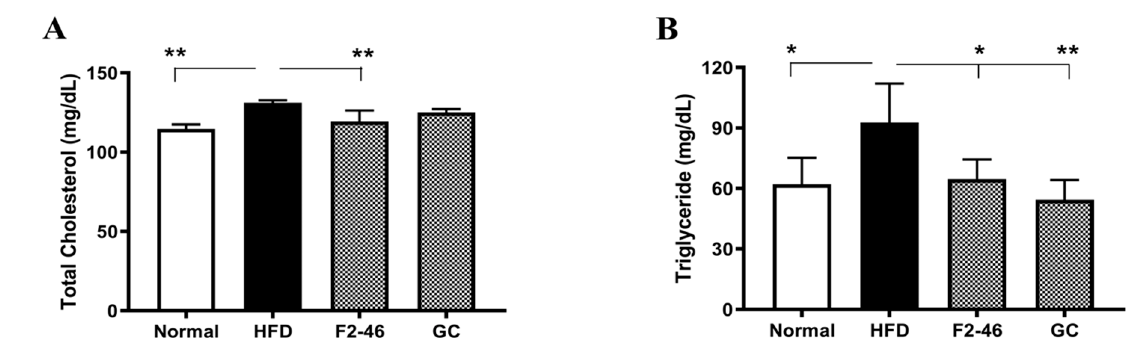
Figure 4. Effect of F2 on the mice serum lipid profile. The ( A ) total cholesterol and ( B ) triglyceride levels were measured in Figure 4. A one-way ANOVA was applied to calculate statistical significance. * p < 0.05; and ** p < 0.01 vs. HFD control. Normal = standard diet; HFD = high-fat diet control; F2-46 = F2 (46 mg/kg); GC = G. cambogia (200 mg/kg).